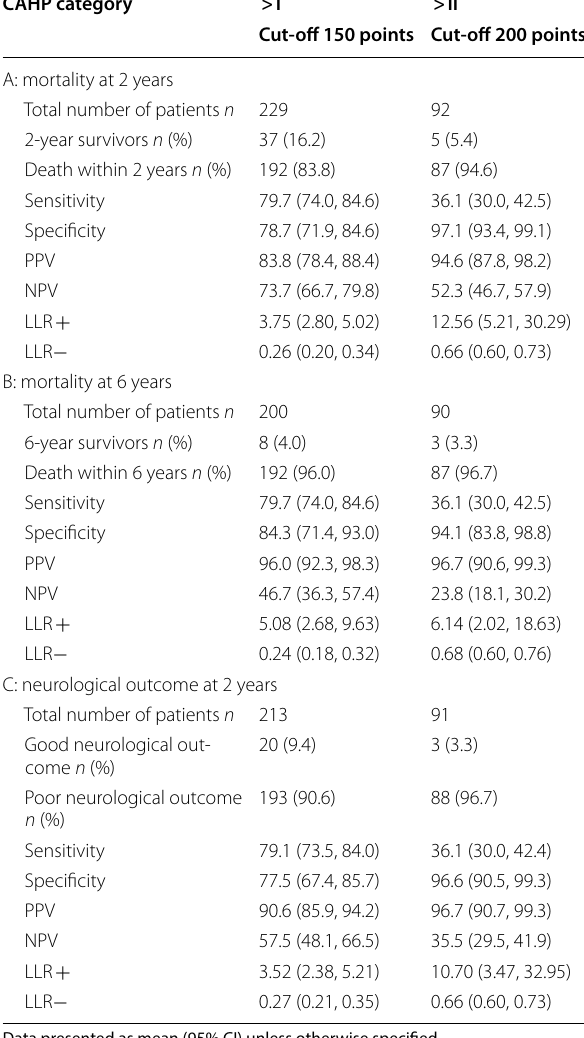
Table 4 Performance of CAHP-Score at different cut-off points